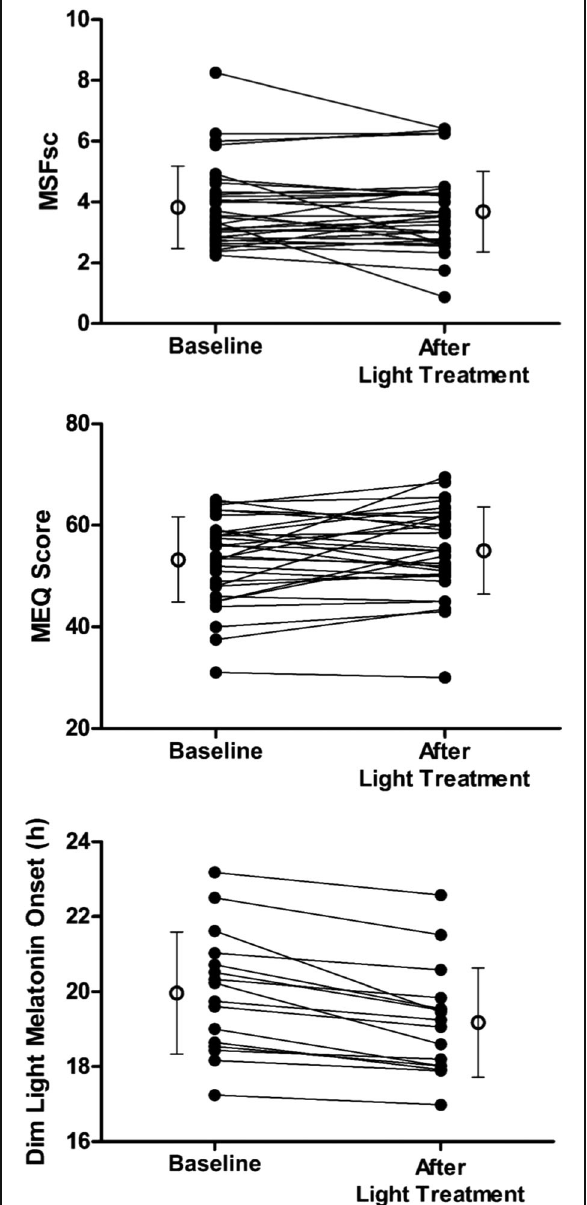
Fig. 1 The changes in MSFsc, MEQ score, and DLMO observed in each individual subject before and after a 13 or 28 day morning light treatment. The results for an individual subject are connected by a line. The mean and standard deviation at each time point is also